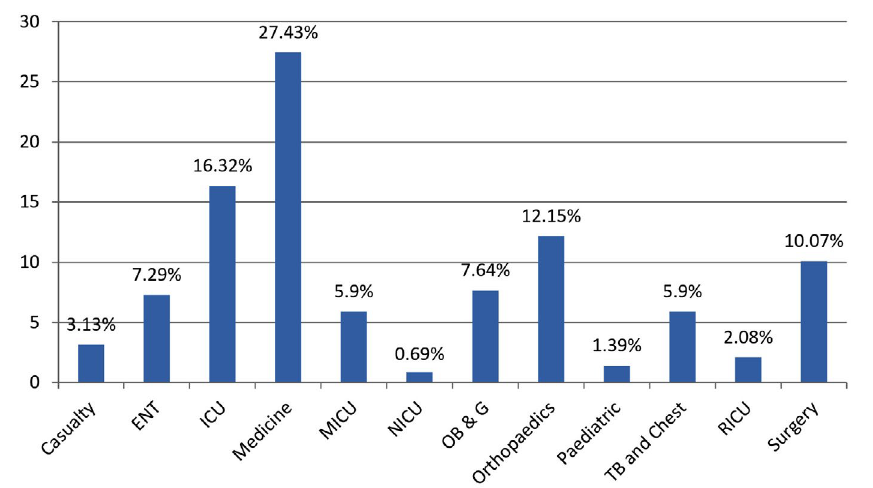
Fig. 1. Sample-Wise Distribution of MRSA Strains.